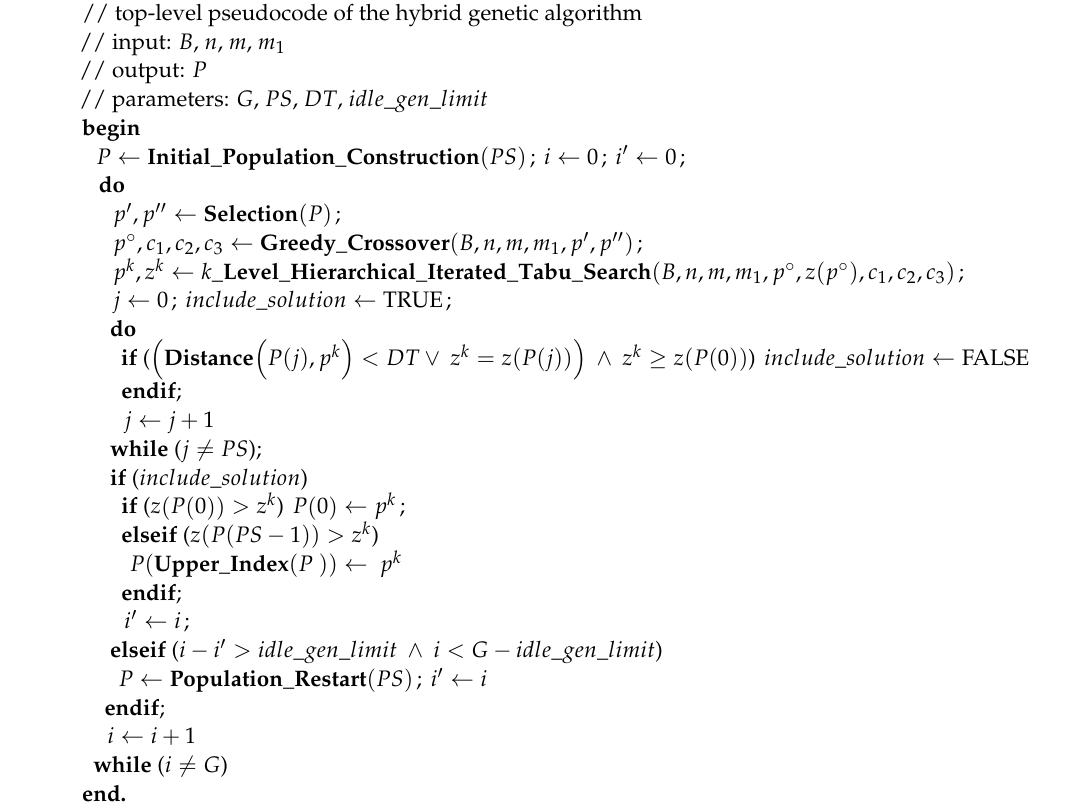
Algorithm 1 Hybrid_Genetic_Algorithm // top-level pseudocode of the hybrid genetic